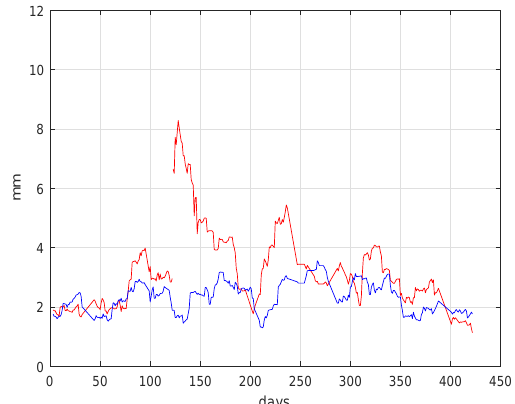
Figure 21. Moving RMS of the residuals of the modelled positions in the Up component for the East point (red line) and the West point (blue